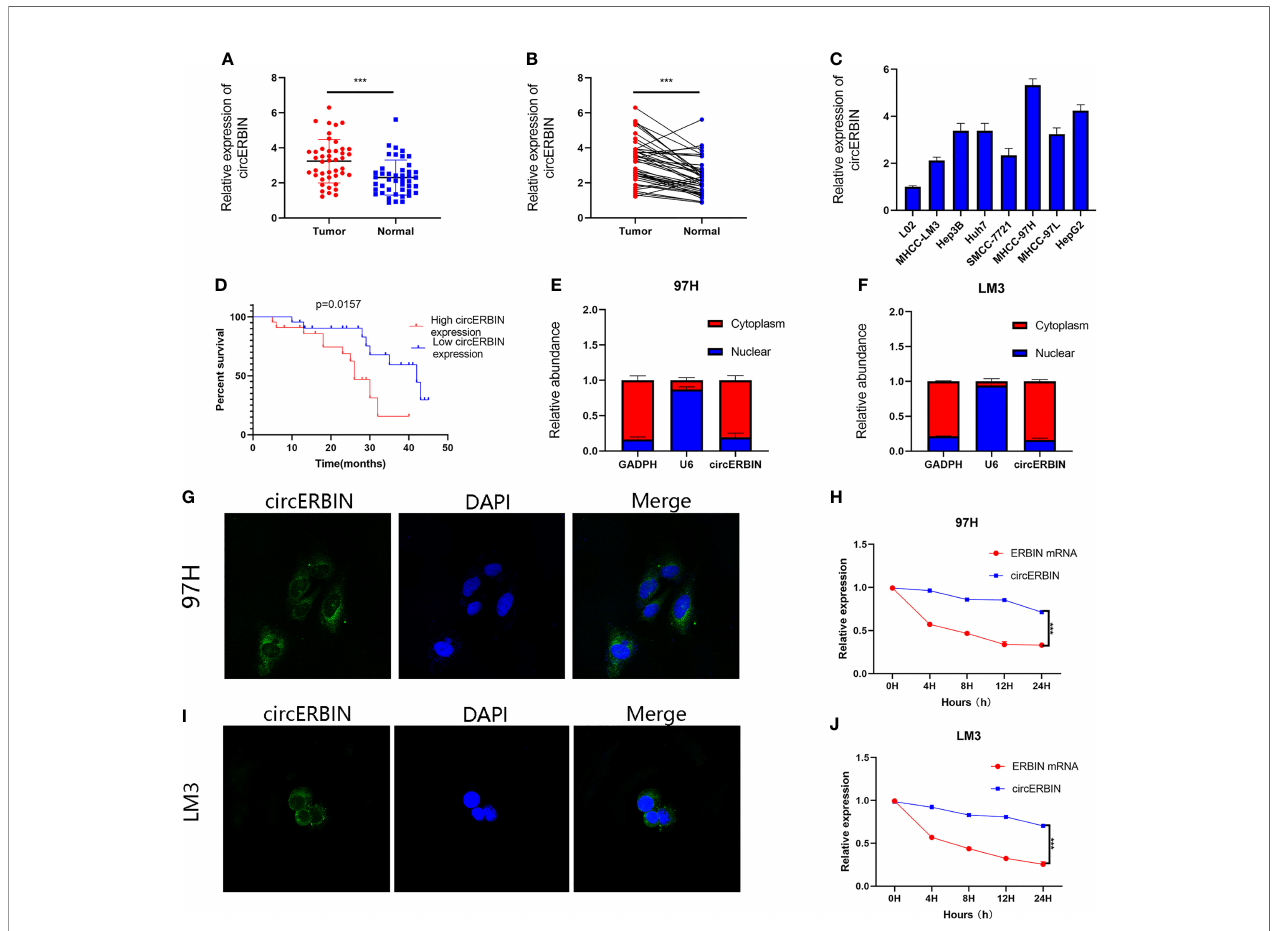
FIGURE 1 | CircERBIN is upregulated in HCC cells and tissues. (A, B) The relative expression of circERBIN was determined in 44 pairs of HCC and para-cancer tissues by qRT-PCR. (C) The relative expression of circERBIN was examined in HCC cell lines by qRT-PCR. (D) Kaplan – Meier survival curve analysis showed that high expression of circERBIN was associated with shorter overall survival of HCC patients. (E, F) qRT-PCR analysis of circERBIN abundance in the cytoplasmic and nuclear fractions of 97H and LM3 cells. GAPDH and U6 were used as positive controls in the cytoplasm and nucleus, respectively. (G, H) FISH was used to determine the localization of circERBIN in HCC cells. (I, J) Time-course qRT-PCR analyses of the relative abundance of circERBIN and linear ERBIN in LM3 and 97H cells treated with actinomycin D (10 m g/mL). (*** p <